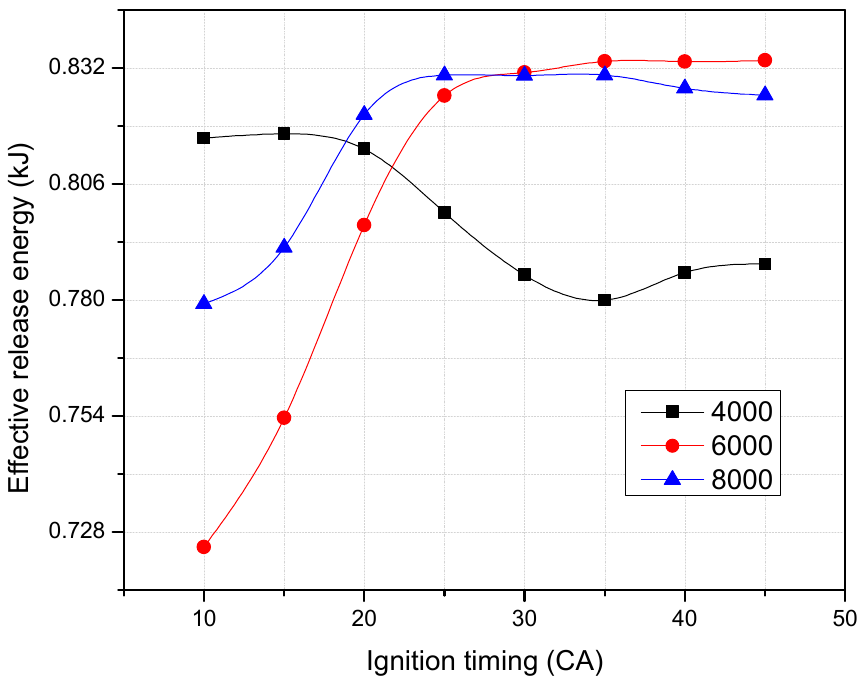
Figure 12. Effective release energy versus ignition timing. The effects of ignition time on BMEP and IMEP are presented in Figures 13 and 14, respectively. The phenomenon can be observed under two stages. In the first stage, BMEP and IMEP rapidly increase to a clear peak value. In the next stage, the trend reverses steadily. At each revolution speed, the optimal values of BMEP and IMEP during the same time the ignition time reached its peak were reported. This can be explained by the phenomenon that the moment of ignition occurs simultaneously with the release of energy. Some noteworthy values are the ignition time benchmark (optimal value) obtained at 9.49 bar on BMEP and 12.09 bar on IMEP at 4000 rpm—20 ◦ CA. Under other conditions (6000 rpm—30 ◦ CA), the optimal value was 9.87 and 12.82 bar on BMEP and IMEP, respectively. Increasing at 8000 rpm and 30 ◦ CA of the ignition time, BMEP and IMEP reached 9.62 and 12.12 bar. This denotes that the ignition time clearly depends on these